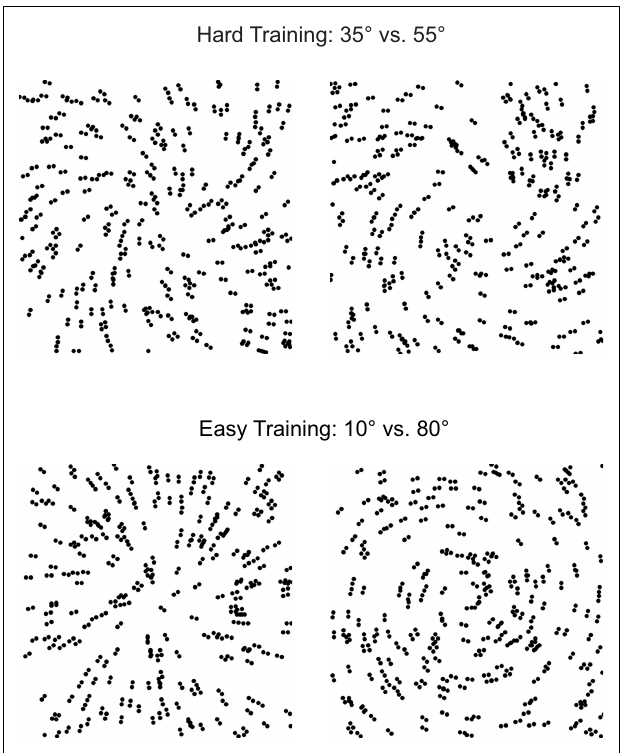
FIGURE 1 | Glass pattern stimuli. Schematics of radial and concentric Glass patterns used for hard (35˚ vs. 55˚) vs. easy (10˚ vs. 80˚)